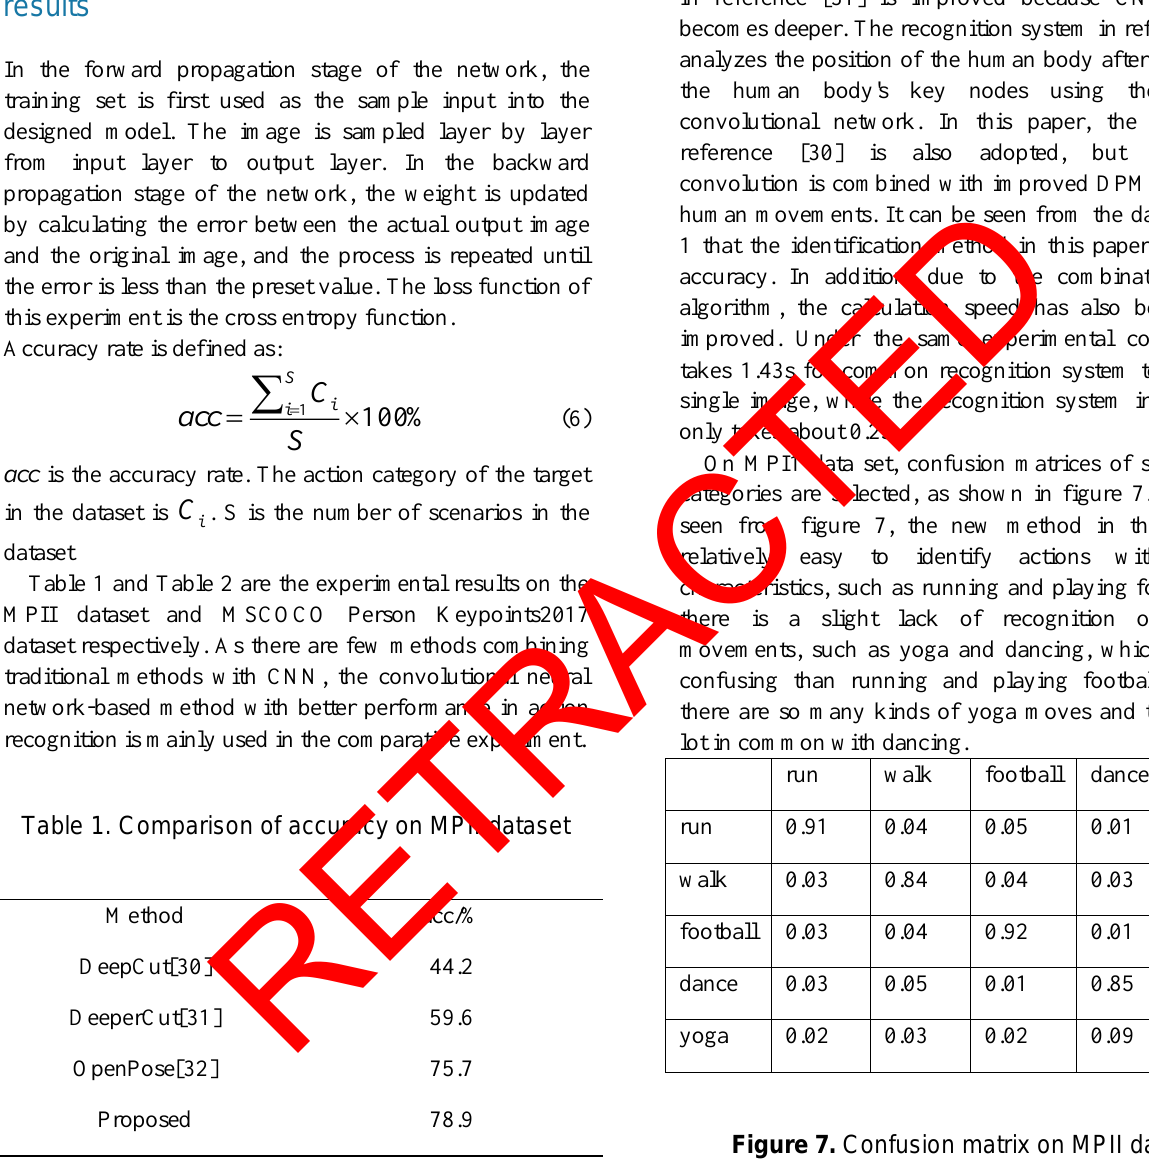
Table 2. Comparison of accuracy on MSCOCO